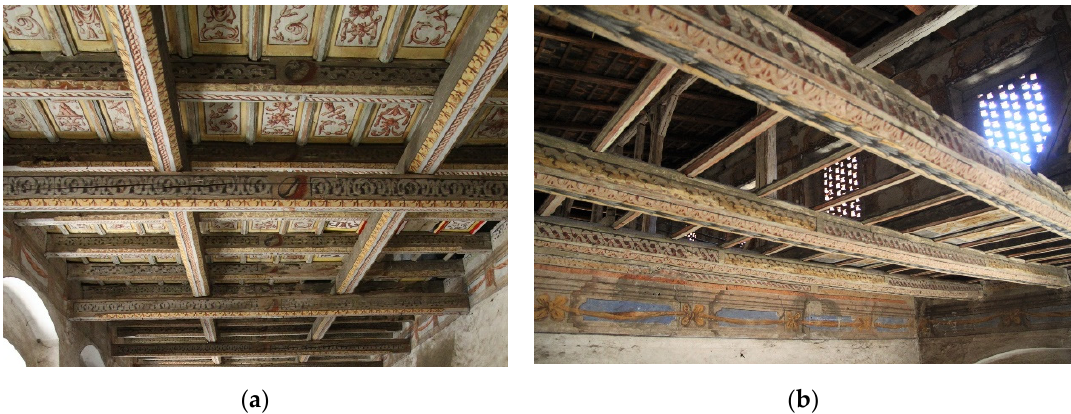
Figure 1. Examples of polychrome ceilings requiring technical condition analysis in Gorzanów Palace, 2015: ( a ) ceiling in a lounge chamber, ( b ) ceiling in a theatre chamber.